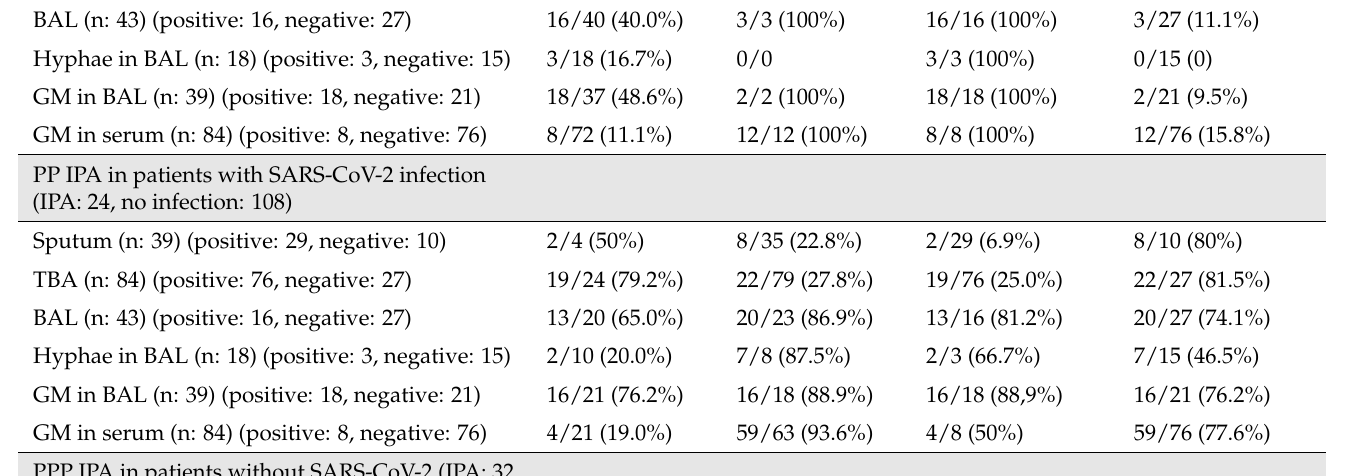
Table 6. Performance of diagnostic approach. Sensitivity Specificity